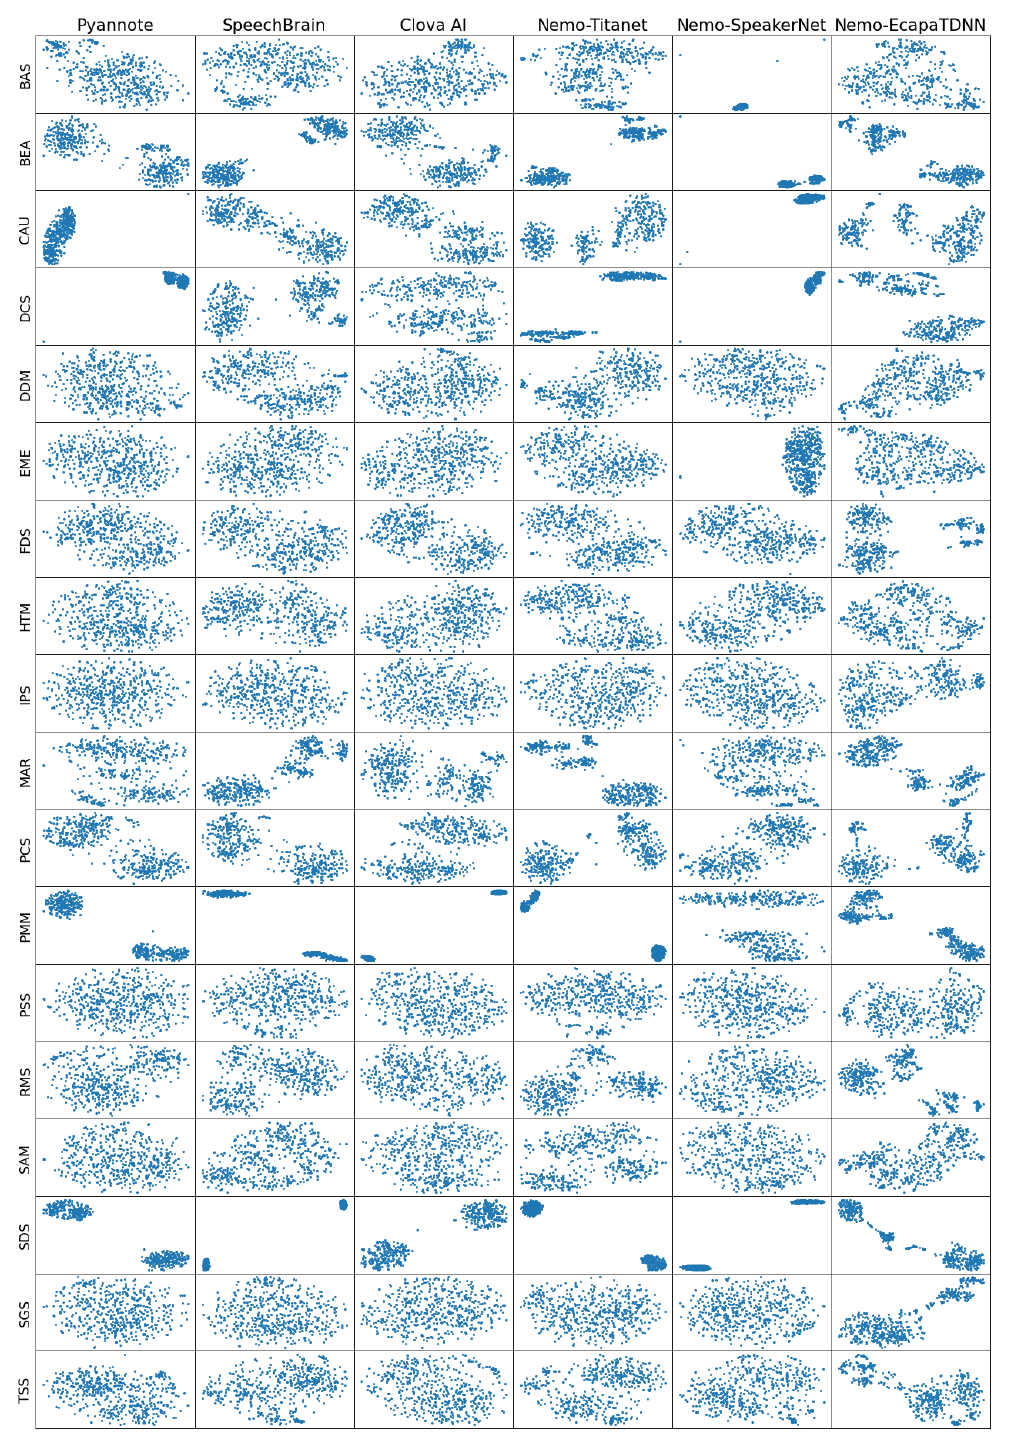
Figure 5. Speaker-level t-SNE plots of the different embedding architectures— SWARA1.0